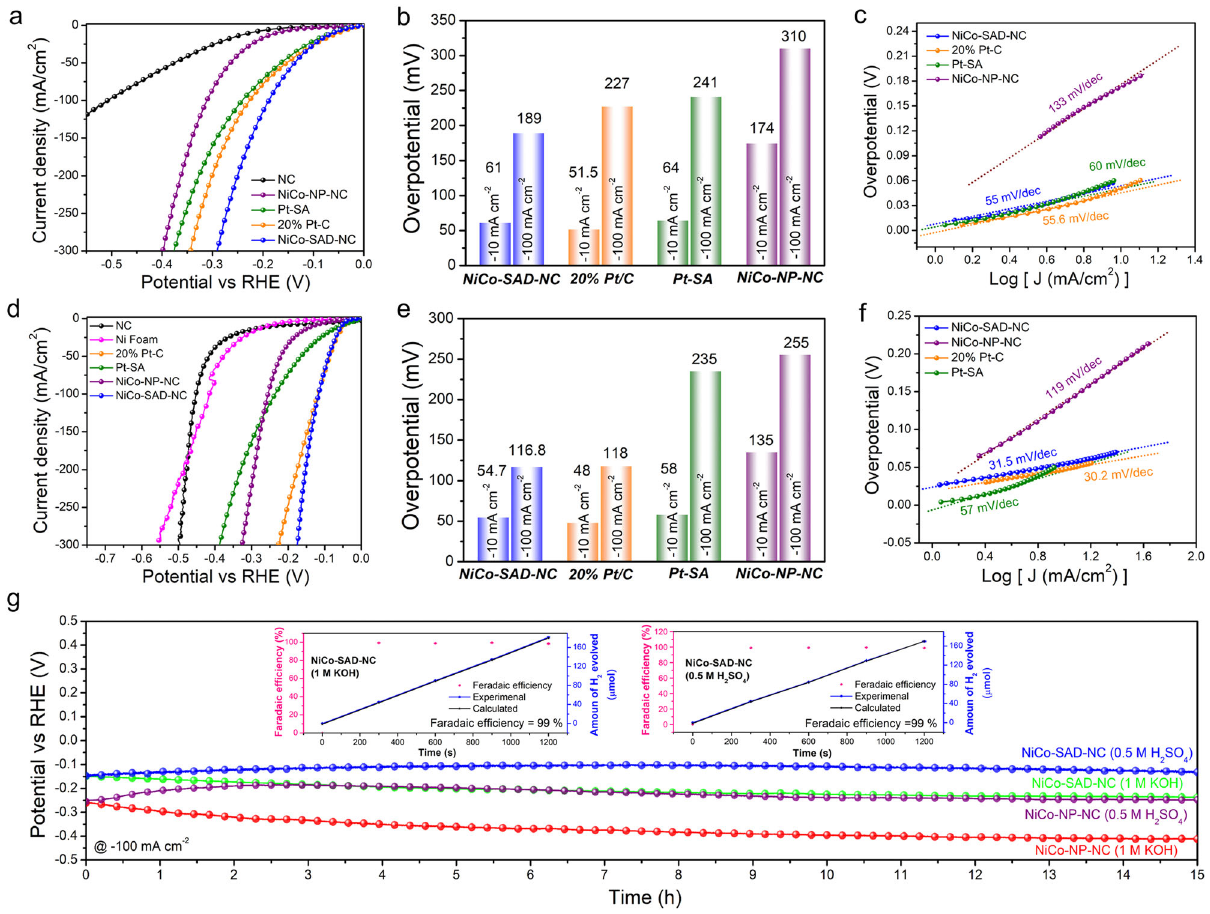
Fig. 5 Electrochemical hydrogen generation performance in alkaline and acidic media. a – c HER LSV polarization curves (iR-corrected) ( a ), the overpotentials required to reach − 10 and − 100mAcm − 2 ( b ), and corresponding Tafel plots ( c ), in 1M KOH. d – f , HER LSV polarization curves (iR-corrected) ( d ), the overpotentials required to reach − 10 and − 100mAcm − 2 ( e ), and corresponding Tafel plots ( f ), in 0.5M H 2 SO 4 . g Chronopotentiometric stability test for NiCo-SAD-NC and NiCo-NP-NC in 0.5M H 2 SO 4 and 1M KOH at a current density of − 100mAcm − 2 . The inset shows the faradaic ef fi ciency of NiCo-SAD- NC for HER at − 100mAcm − 2 in 0.5M H 2 SO 4 (right) and 1M KOH